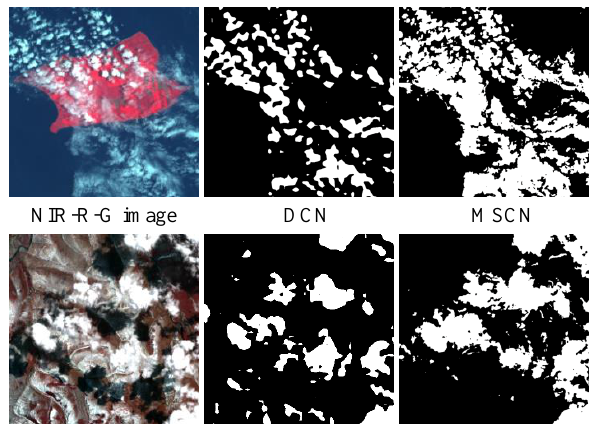
Figure 5. Cloud detection results of MSCN and